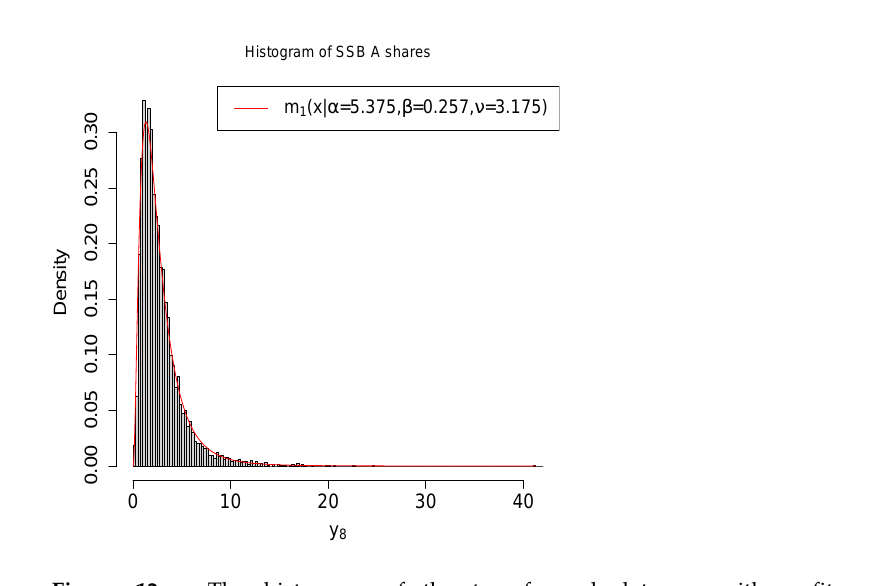
with a fit marginal density 8